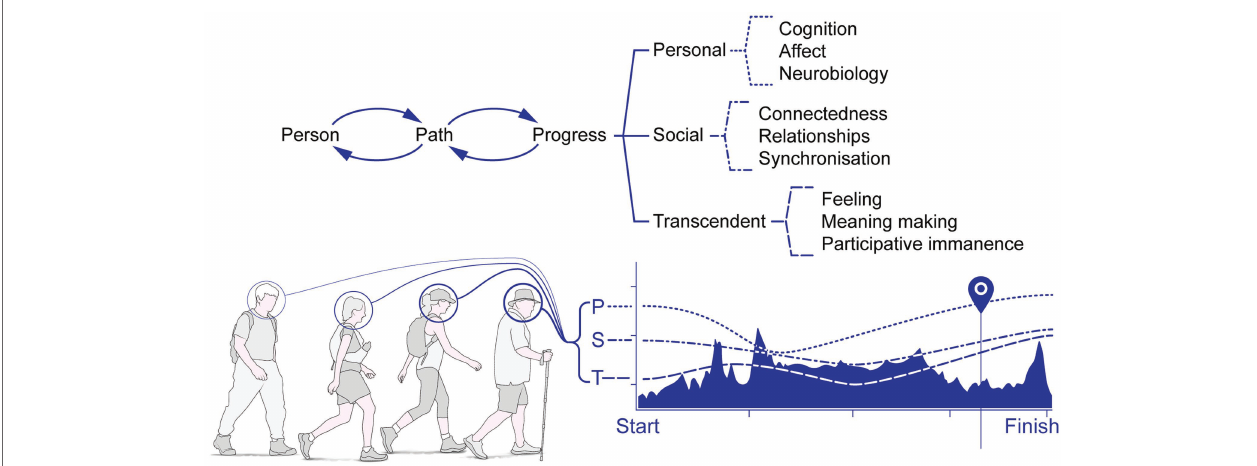
FIGURE 3 | Transcendence: PW is undertaken for secular and/or religious reasons, particularly of feeling, meaning-making and participative immanence. Personal, social and transcendent states may vary across the walking pilgrimage, depending on a variety of factors (such as terrain strain, motivation and feelings towards the group, for